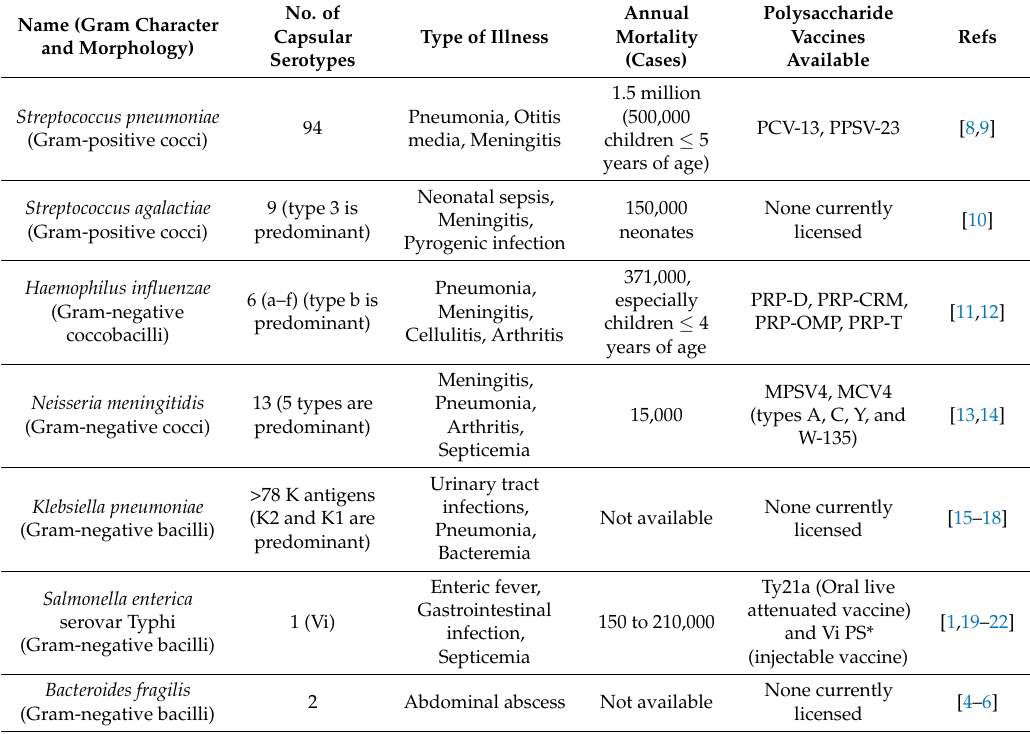
Clinically important encapsulated bacteria and vaccines. PCV13, Pneumococcal polysaccharide conjugate vaccine 13; PPSV23, Pure pneumococcal polysaccharide vaccine 23. PRP-D, polyribosyl-ribitol-phosphate-Diphtheria toxoid (DT) conjugate vaccine; PRP-CRM, PRP-conjugate vaccine containing CRM197, a mutated DT protein; PRP-OMP, PRP conjugate vaccine containing meningococcal outer membrane protein; PRP-T, PRP conjugate vaccine containing tetanus toxoid. MPSV4, Tetravalent meningococcal polysaccharide vaccine; MCV4, tetravalent meningococcal polysaccharide conjugated with diphtheria toxoid or diphtheria CRM197 protein. Vaccines against N. meningitidis type B are directed to surface proteins rather than capsular polysaccharides. K antigens, surface exposed capsular polysaccharides in K. pneumoniae. Vi, Virulence antigen (shared capsular polysaccharides). A Vi-protein conjugate vaccine is in late-stage Phase 3 testing for efficacy, particularly in young